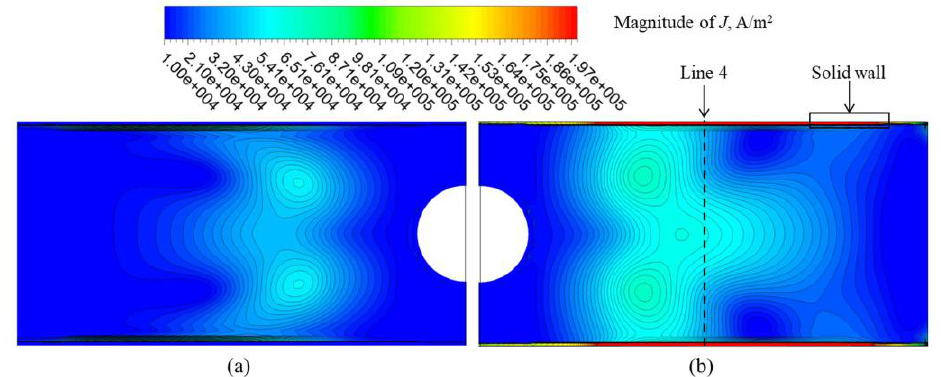
Figure 10. Contours of time-averaged induced electrical current density on plane 1 (Figure 2) for: ( a ) EMBr with electrically-insulated walls; ( b ) EMBr with electrically-conducting walls.